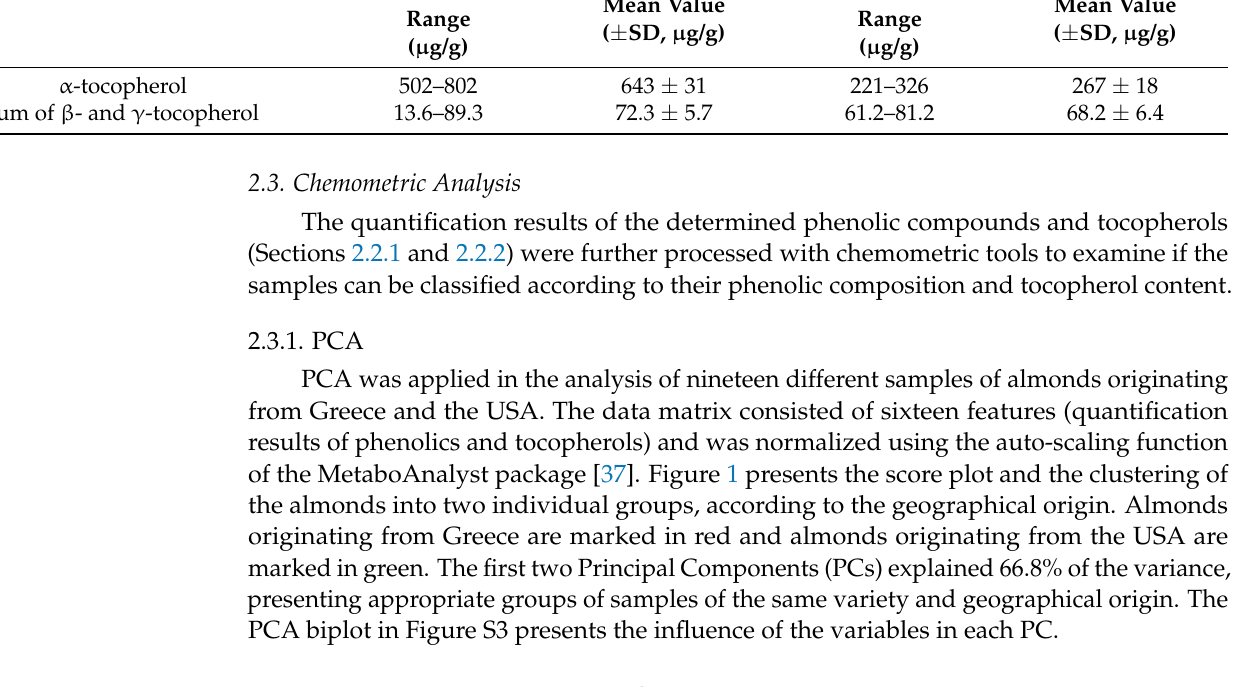
Table 2. Tocopherols’ quantification results in Greek and American almonds (samples analyzed in triplicate, n = 3). Tocopherol